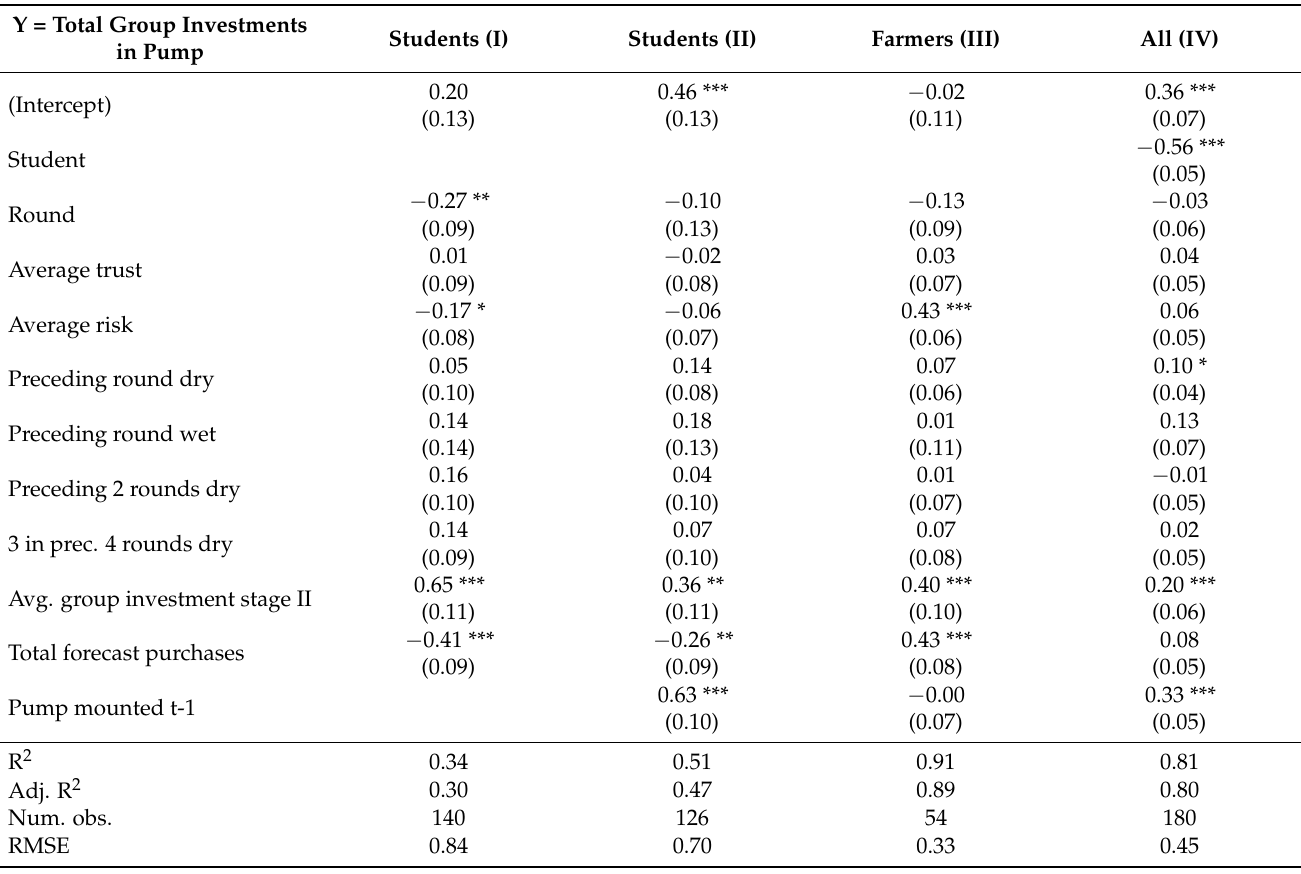
Table 6. Group level regression results (Group investments in